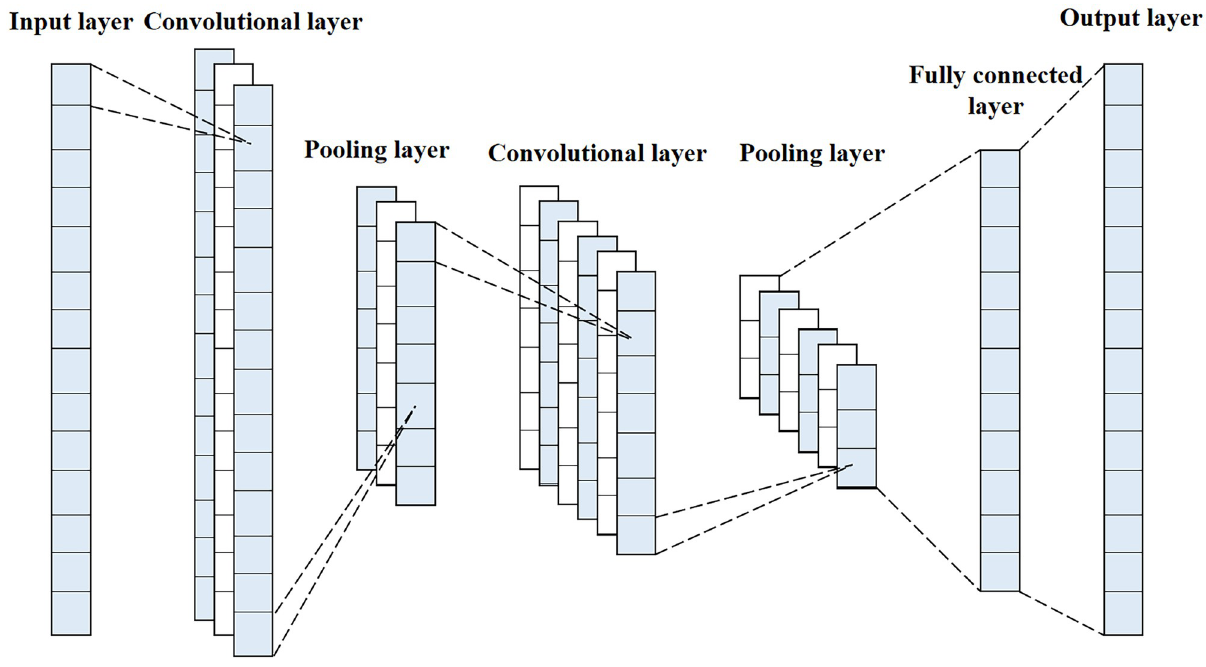
Fig 3. Convolutional neural network